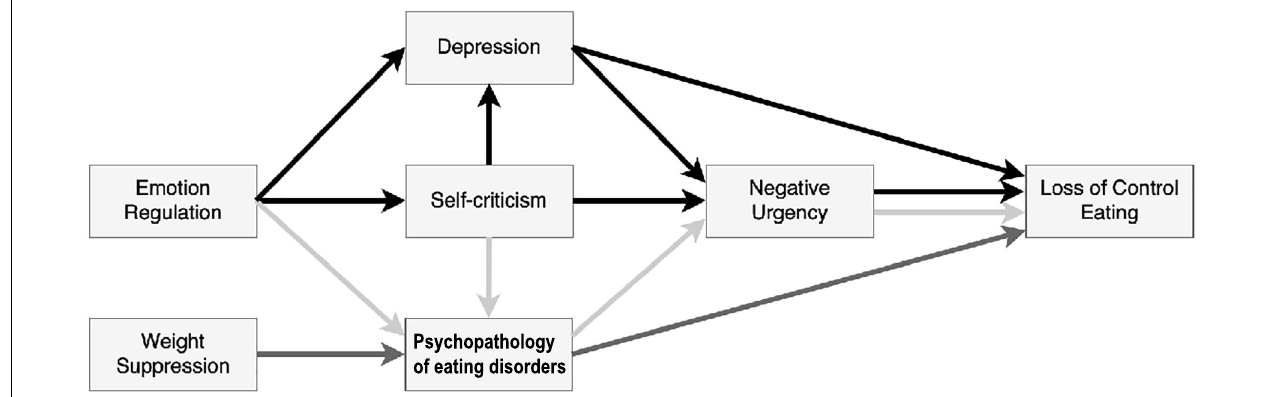
FIGURE 1 | Hypothesized model depicting the interplay between disordered eating-related variables and other psychological variables to explain loss of control (LOC) eating. Path 1 – Psychopathology of eating disorders and LOC eating; Path 2 – emotion and behavior regulation under distress; and Path 3 – interplay between Path 1 and Path